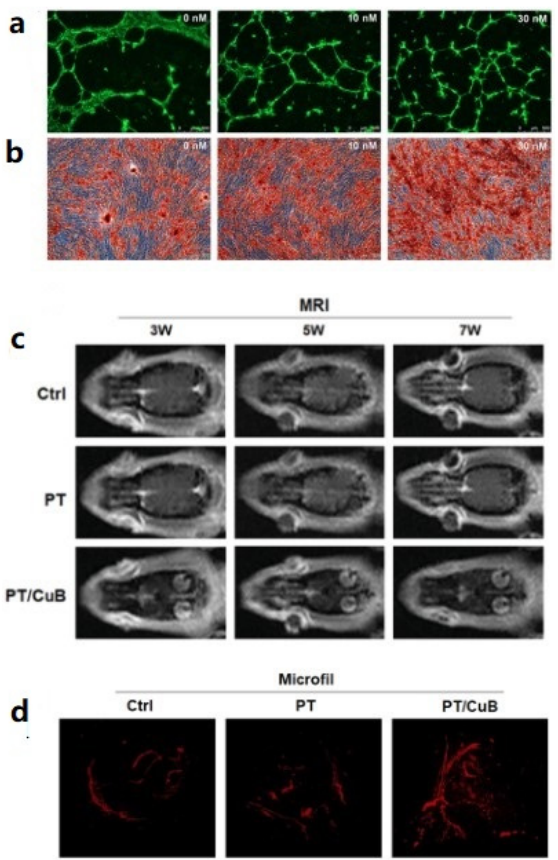
Figure 5. CuB has excellent performance of angiogenesis and osteogenesis. ( a ) In vitro angiogenesis, ( b ) alizarin red staining graph to evaluate osteogenic performance, ( c ) MRI scan image of animal model, and ( d ) micro-CT to evaluate in vivo vascularization capacity after 8 weeks, Reprinted with permission from ref. [50]. Copyright 2021